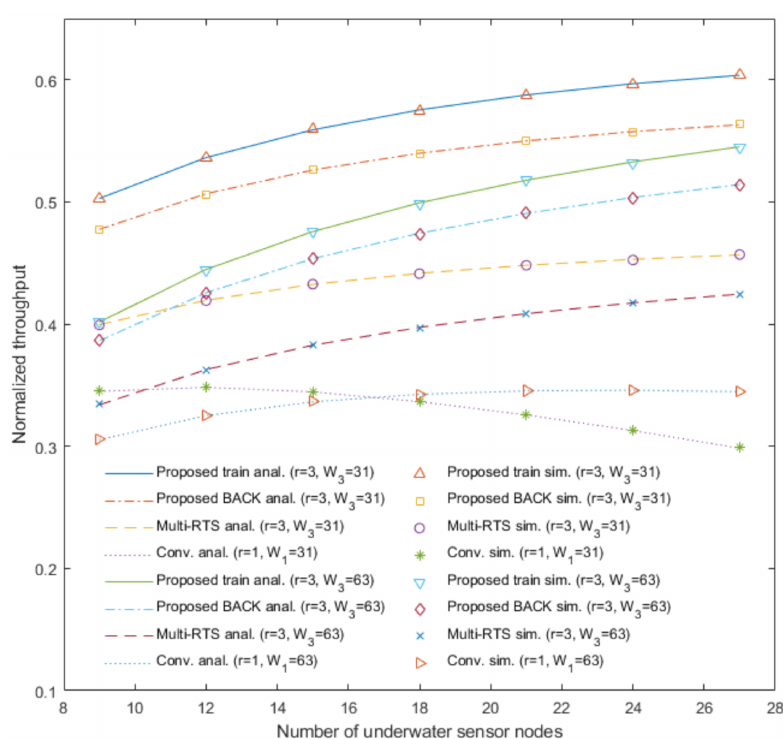
Figure 4. Normalized throughput of the proposed underwater multi-DATA train protocol, the proposed underwater BACK protocol, and the underwater multi-RTS reception protocol with W 3 = 31 and W 3 = 63, and the conventional CSMA / CA protocol with W 1 = 31 and W 1 = 63.